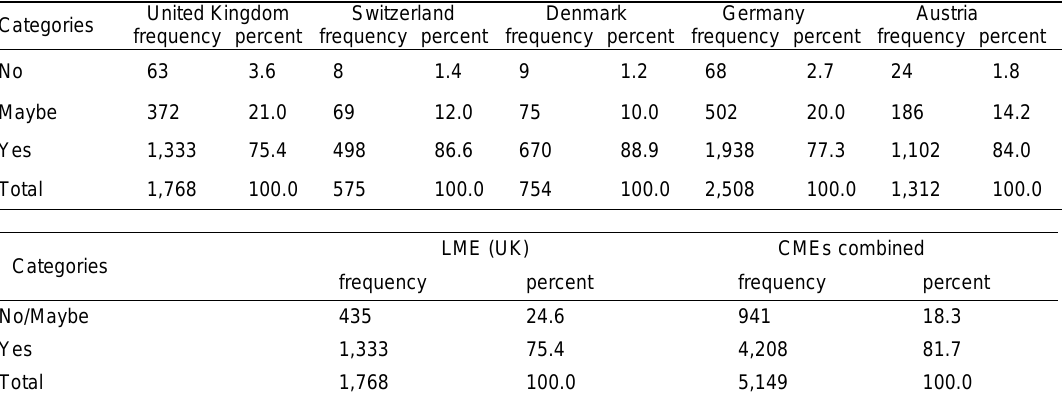
Table 5. Responses to the willingness to retrain vs. learning new